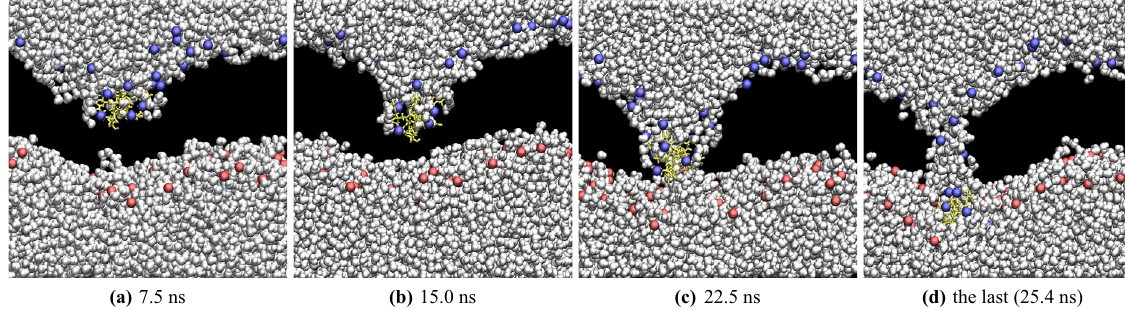
Figure 3. Water molecules near Arg 9 at ( a ) 7.5 ns, ( b ) 15.0 ns, ( c ) 22.5 ns, and ( d ) the last (25.4 ns). (yellow: Arg 9 , white: water, blue & red : phosphorus atoms of the upper leaflet & lower leaflet, respectively). The water flow and the movement of Arg 9 are correlated with each